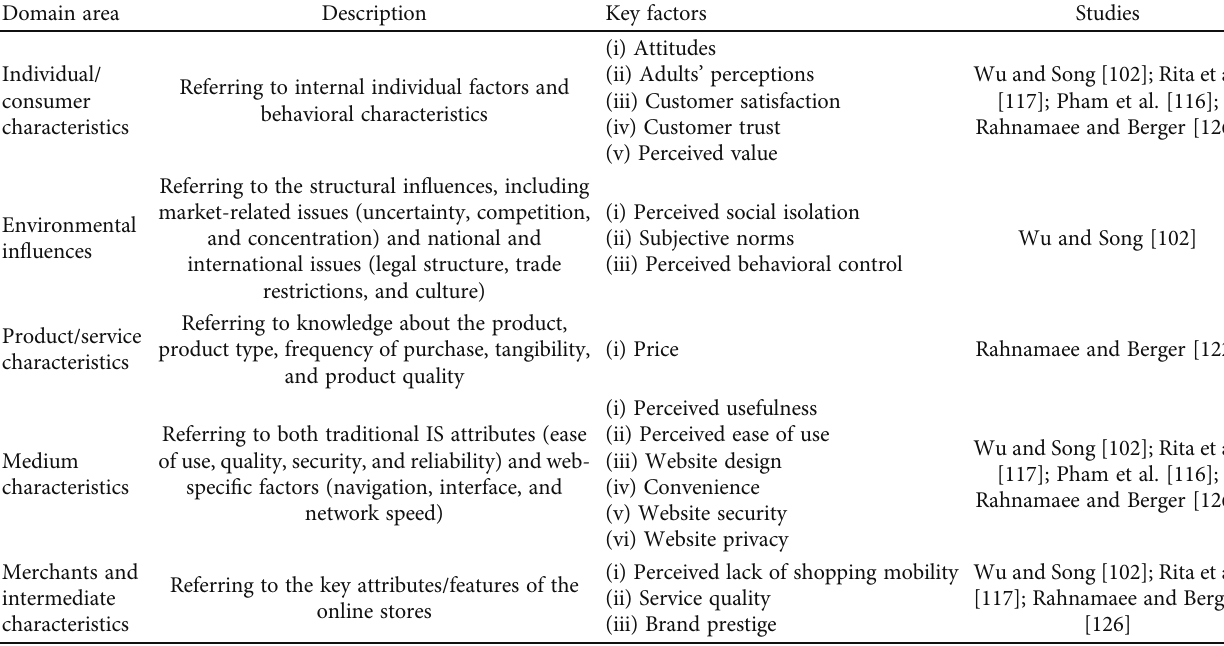
Table 4: Determinants of online consumer behavior